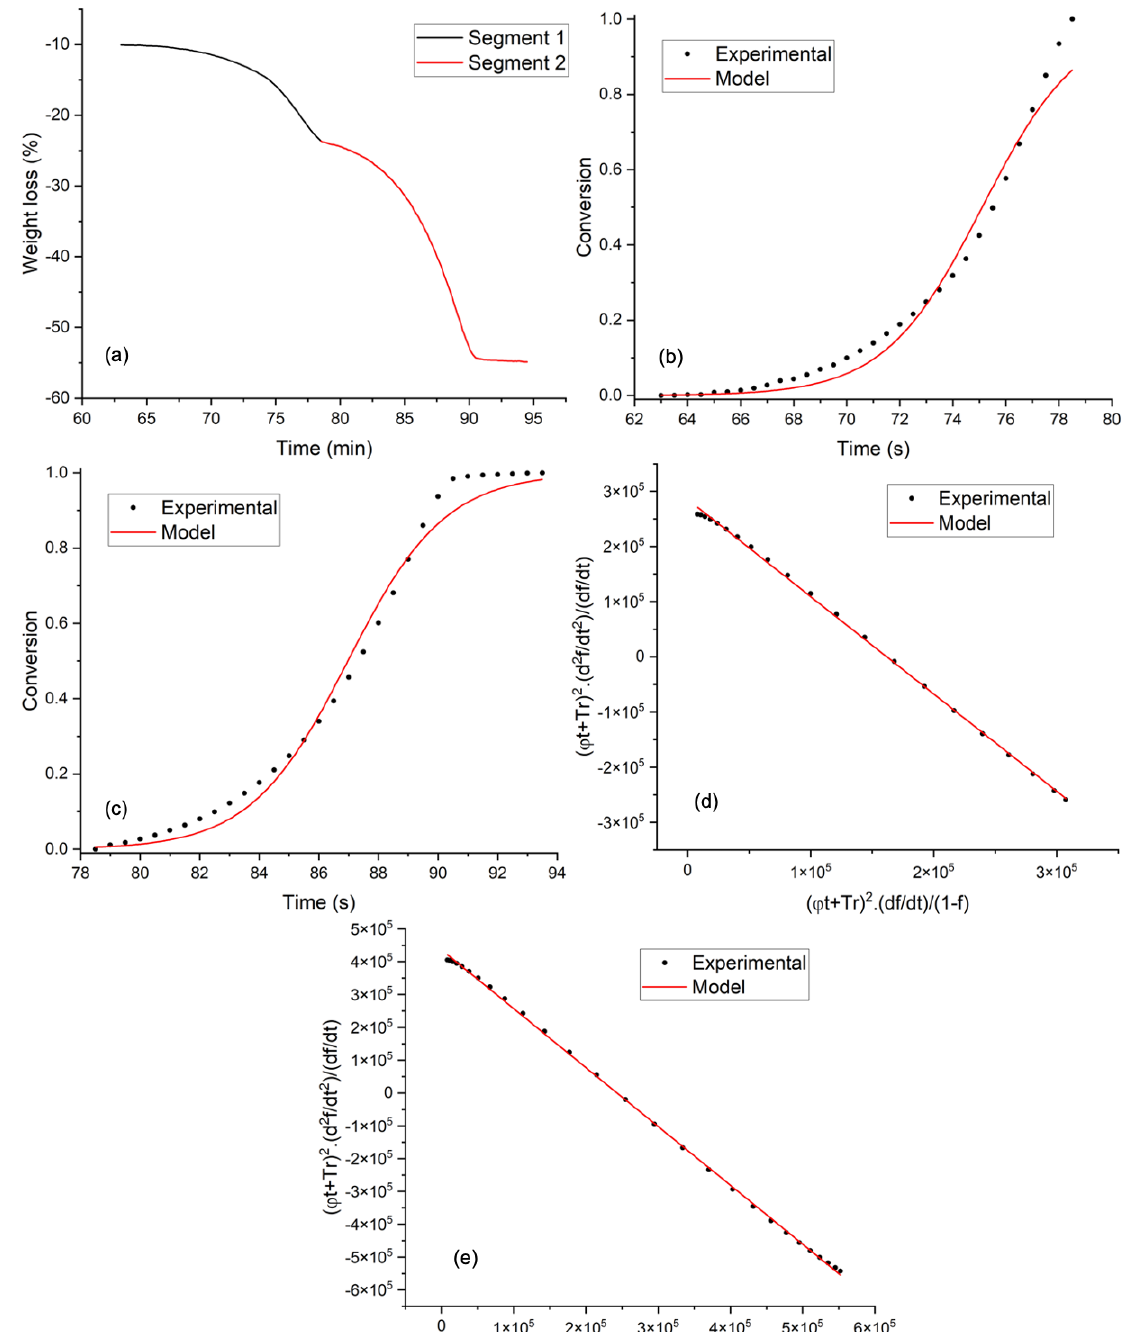
Figure 5. Graphical adjustments for thermal decomposition of ZnSO 4 · H 2 O: ( a ) segmentation of the sample mass variation; ( b ) conversion fraction of Step 1 as a function of temperature; ( c ) conversion fraction of Step 2 as a function of temperature; ( d ) linearization of conversion data associated with Step 1 segment; ( e ) linearization of conversion data associated with Step 2 segment.